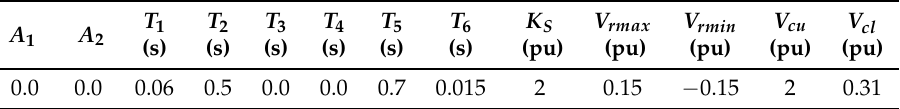
Table A3. PSS parameters (type IEEE